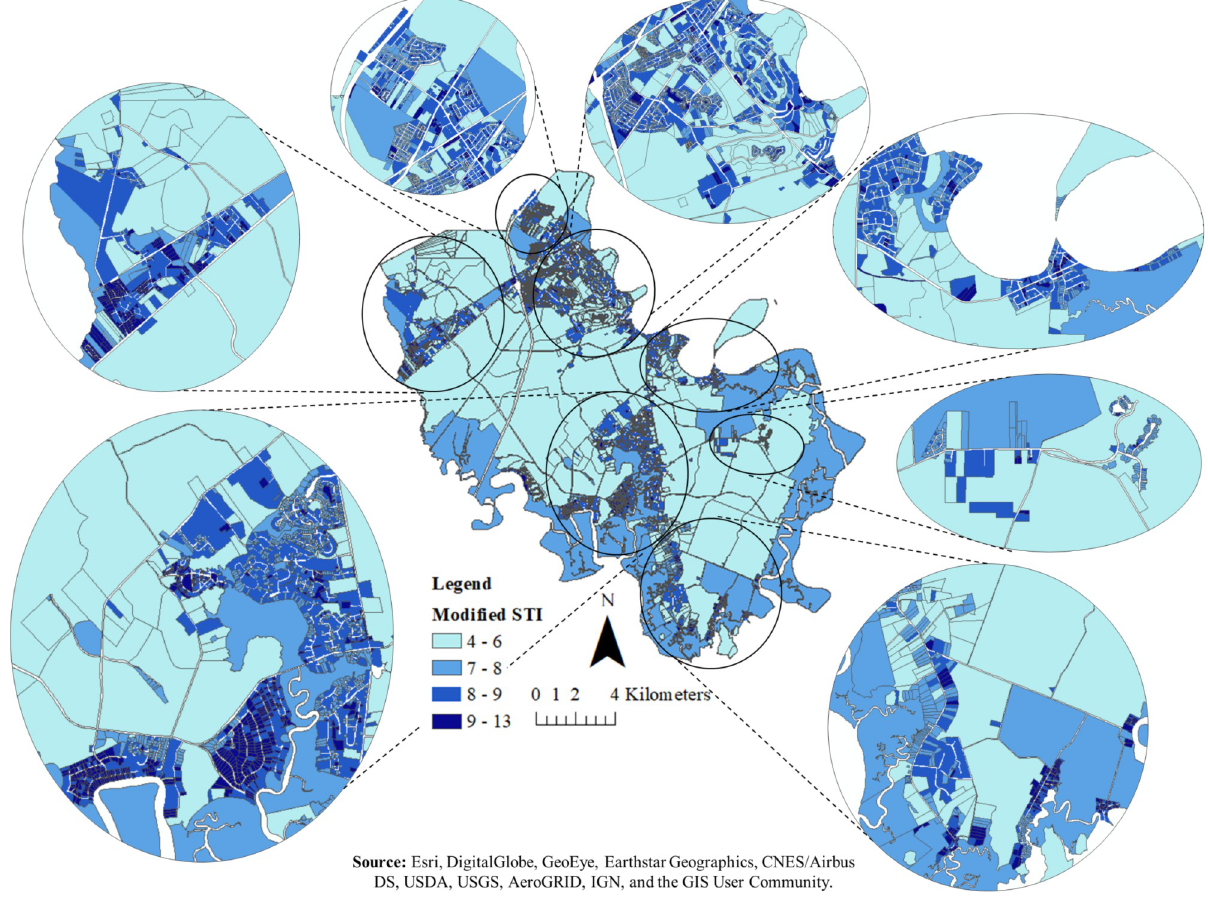
Fig 5. The map of modified STI for all parcels in the southern part of Bryan County. The modified STI for parcels smaller than 0.04 km 2 (10 acres) was calculated as a mean of the modified STI for each pixel within that parcel and for parcels equal or greater than 0.04 km 2 (10 acres) was calculated as a mean of the modified STI minus one standard deviation of each pixel within that parcel. Small numbers represent dryer soil conditions and large numbers represent wetter soil conditions.